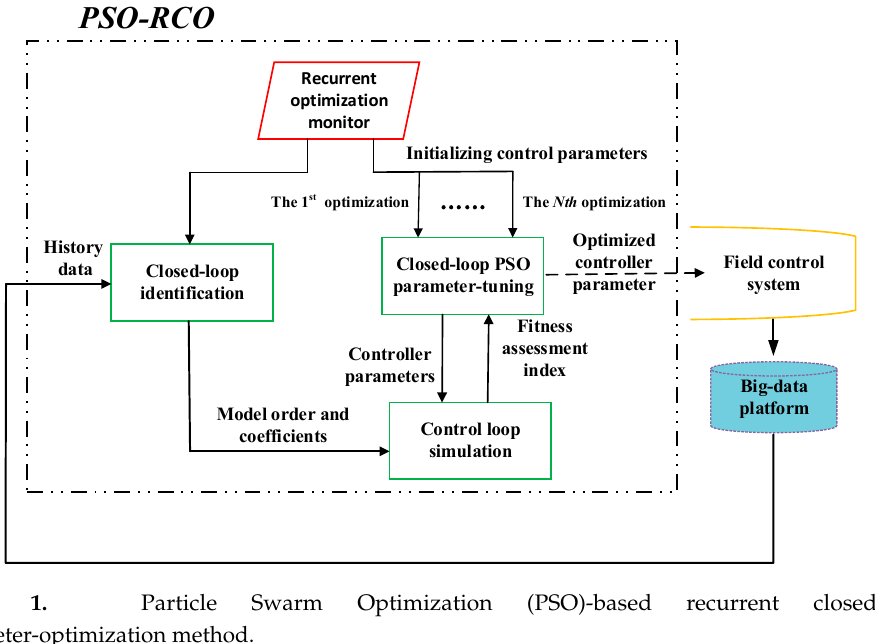
Figure 1. Particle Swarm Optimization (PSO)-based recurrent closed-loop parameter-optimization method.